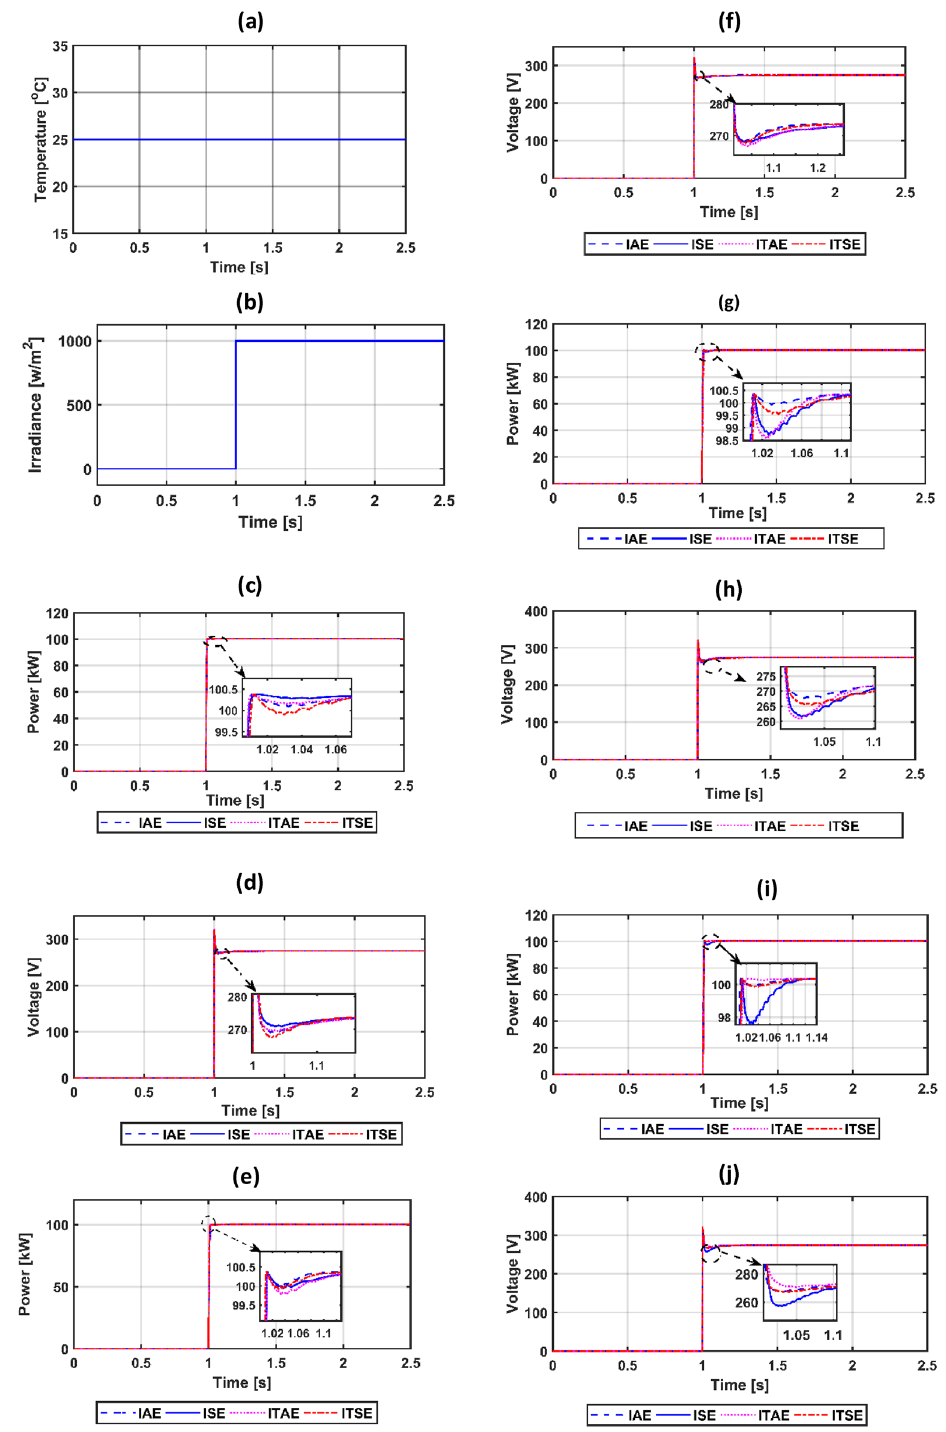
Figure 8. ( a ) constant temperature at 25 °C, ( b ) step irradiance, ( c ) PV output power-based AOA, ( d ) PV voltage-based AOA, ( e ) PV power-based GWO, ( f ) voltage of the PV-based GWO, ( g ) PV power -based GA, ( h ) voltage of the PV-based GA, ( i ) PV power-based PSO, ( j ) voltage of the PV-based